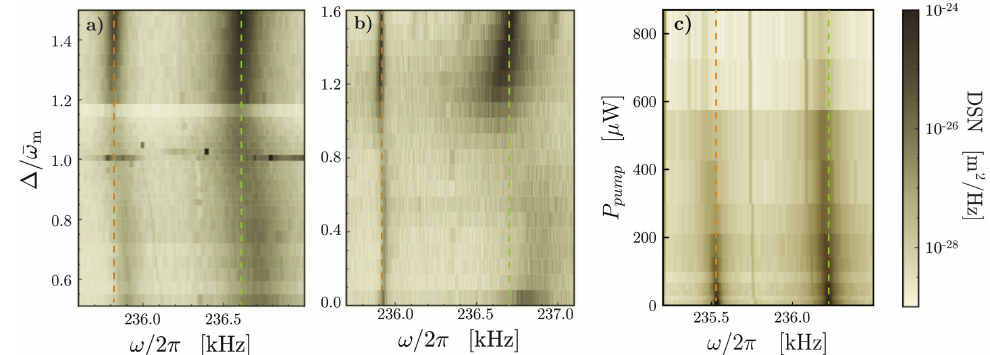
Figure 4. Laser cooling of the two membranes. Measured displacement spectral noise (DSN) as a function of the detuning ∆ normalized to the mean mechanical frequency ¯ ω m = ( ω m 1 + ω m 2 ) /2 of the fundamental modes of the two membranes, for a cooling input power: ( a ) P pump = 130 µW, and ( b ) P pump = 380 µW. The cavity decay rate is κ i = 2 π × 83 kHz. Note the lower optomechanical coupling of the left mode for the results in panel ( b ), which corresponds to an ineffective optical cooling. The orange- and green-dashed lines indicate the mechanical frequencies in the absence of the optical spring effect caused by the pump. ( c ) Laser cooling of the two membranes at constant detuning ∆ ∼ ¯ ω m . The DSN is measured as a function of the cooling beam power P pump . The orange- and green-dashed lines indicate the mechanical frequencies with no cooling. At P pump = 0 the cooling beam is switched off, and we appreciate the thermal noise of the fundamental modes of the two membranes.